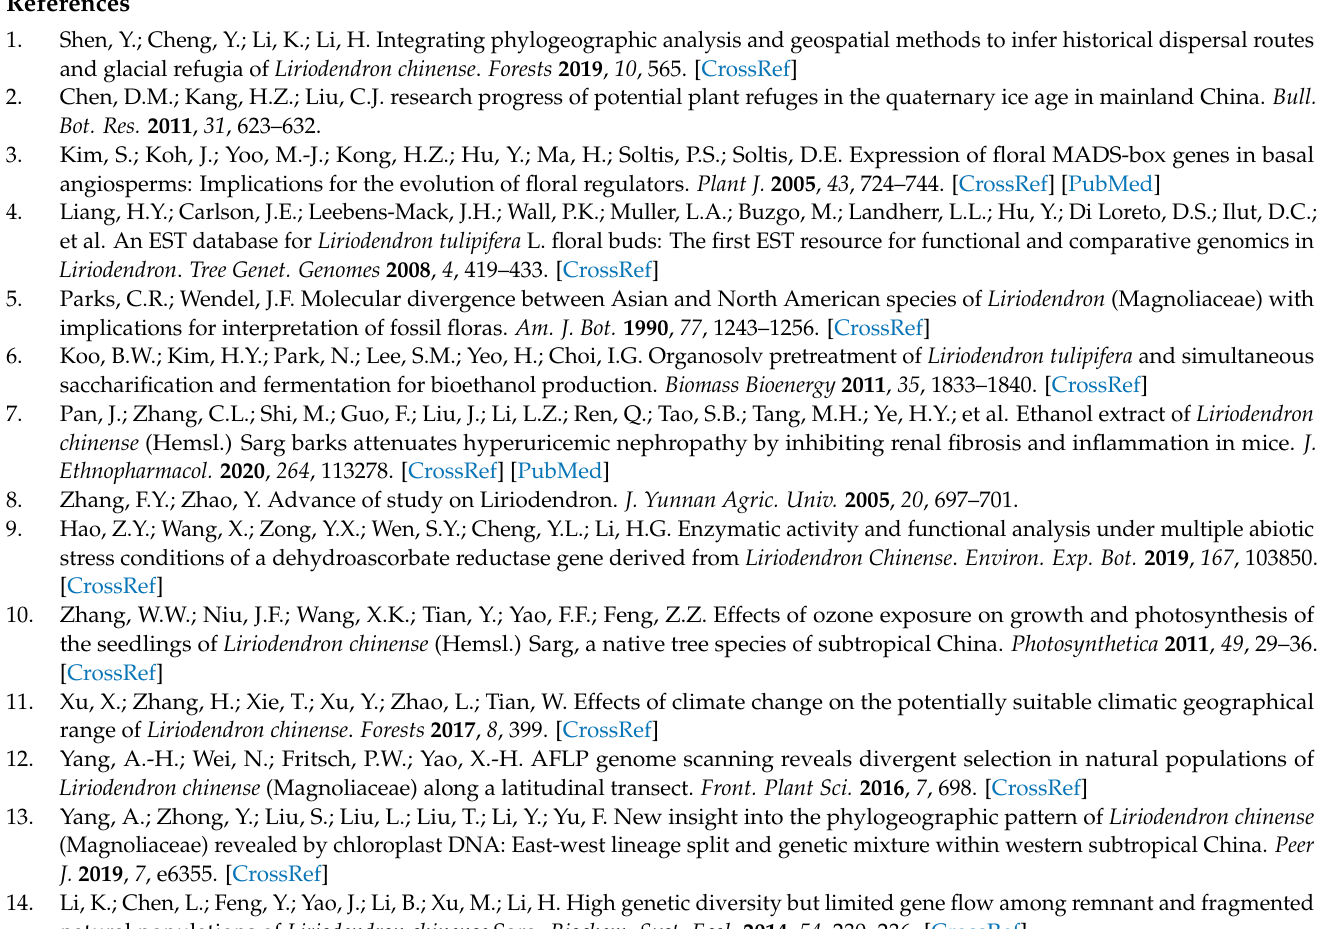
STRUCTURE analysis, Figure S6. Population genetic structure based on the Bayesian clustering model among 871 samples at K = 21. Numbers correspond to the population numbers in Table 1, Figure S7. UPGMA tree based on Nei’s genetic distances. Numbers correspond to the population numbers in Table 1, Figure S8. Score plot generated using